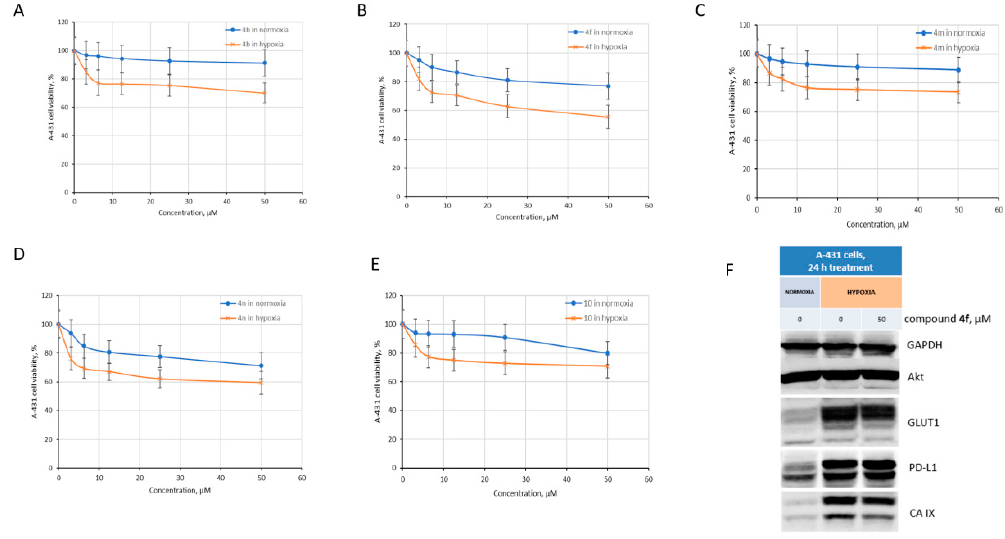
Figure 5. The activity of compounds 4b , f , m , n and 10 against A431 skin cancer cells in normoxia and hypoxia. ( A – E ) antiproliferative evaluation; ( F ) immunoblotting with antibodies against Akt, GLUT1, PD-L1, CA IX; GAPDH antibodies were used as loading controls. Compound 4f was the most active under hypoxic conditions, inhibiting the growth of A431 cells by 44%. We wondered whether compound 4f affected CA IX expression or whether its activity was limited to inhibiting the enzyme activity reported above (Table 1). To induce CA IX expression, cells were placed in hypoxia for 24 h, and then protein expression was analyzed by immunoblotting. Because the data on the expression of hy- poxia-related proteins in the literature are highly inconsistent, we introduced additional controls. Antibodies to hypoxia-regulated and “non-hypoxic” proteins were used [68,69]. The expression of kinase Akt, which is not regulated directly by hypoxia/HIF-1 α , was not altered under hypoxia conditions (Figure 5F). On the contrary, the expression of proteins (CA IX, PD-L1, GLUT1) associated with hypoxia pathways was significantly increased. Thus, these data again support a high expression of CA IX in A431 cells. In A431 cells treated with compound 4f , a moderate decrease in CA IX expression was observed, whereas the expression of hypoxia-regulated proteins PD-L1 and GLUT1 did not change. Thus, lead compound 4f not only blocks the enzyme activity of CA IX, but also causes partial inhibition of hypoxia-induced CA IX expression in skin cancer cells. Next, we examined the activity of the whole series of indoline-5-sulfonamides against leukemia cell line K562. Surprisingly, among all tested compounds, only perfluoro deriv- ative 4e demonstrated significant activity and inhibited the growth of the cells at 10 µM. Other indoline derivatives showed low activity against K562 cells at 50 µM or the highest concentrations. Earlier, Kopecka and colleagues have shown that CA XII can interact with P-gp and influence its activity [27]. Subsequently, silencing or inhibition of CA XII by chemical agents may restore the sensitivity to Dox of resistant K562 and other tumor cells [70,71]. Given the potent inhibition of 4f against CA XII and the activity of 4e against K562, we examined their ability to reverse the chemoresistance of K562/4 with P-gp to Dox. MTT- test results summarized in Figure 6 show that 4e and 4f have low cytotoxic activity against MDR subline K562/4 as monoagents. However, treatment of K562/4 cells with